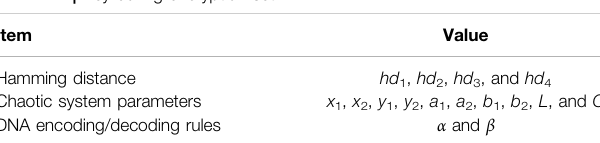
TABLE 4 | Key during encryption